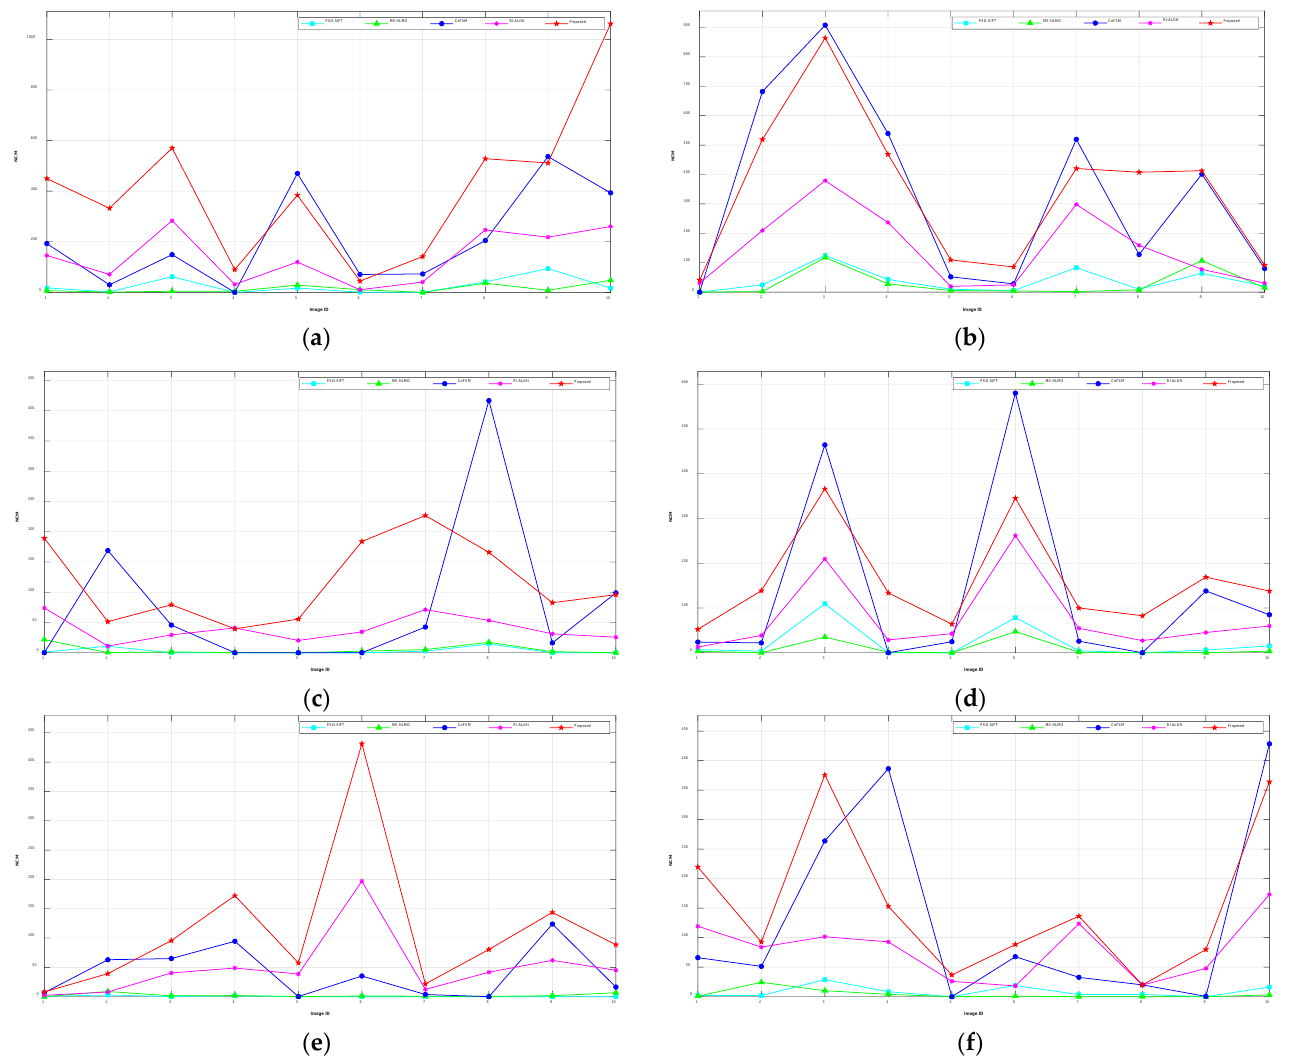
Figure 8. Comparative results for the NCM metric: ( a ) optical–optical; ( b ) optical–infrared; ( c ) optical–depth; ( d ) optical–map; ( e ) optical–SAR; and ( f ) day–night. The mean SR and NCM of each method for all the tested image pairs are shown in Table 5. Compared with PSO-SIFT, MS-HLMO, CoFSM, and RI-ALGH, the mean SR of RI-LPOH was 170.3%, 279.8%, 81.6%, and 25.4% higher, respectively; the mean NCM was